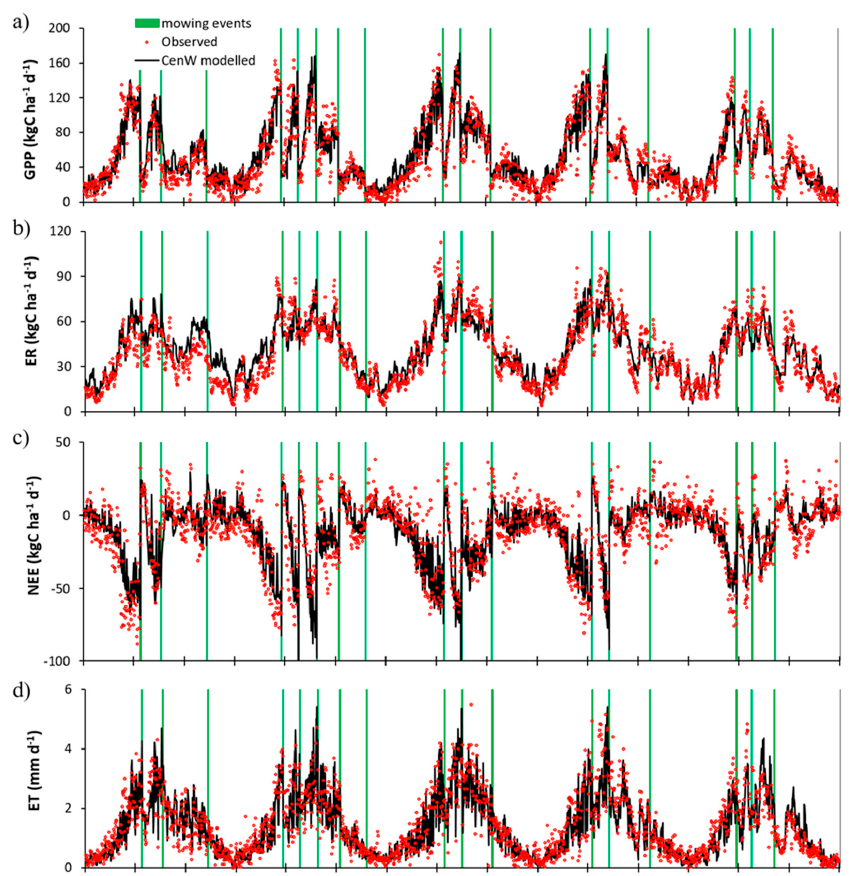
Figure 6. Time series of modeled (black line) and observed (red dots) daily carbon fluxes ( a ) GPP, ( b ) ER, and ( c ) NEE, and water fluxes ( d ) ET for the mowed grassland site. Vertical green lines represent mowing events.